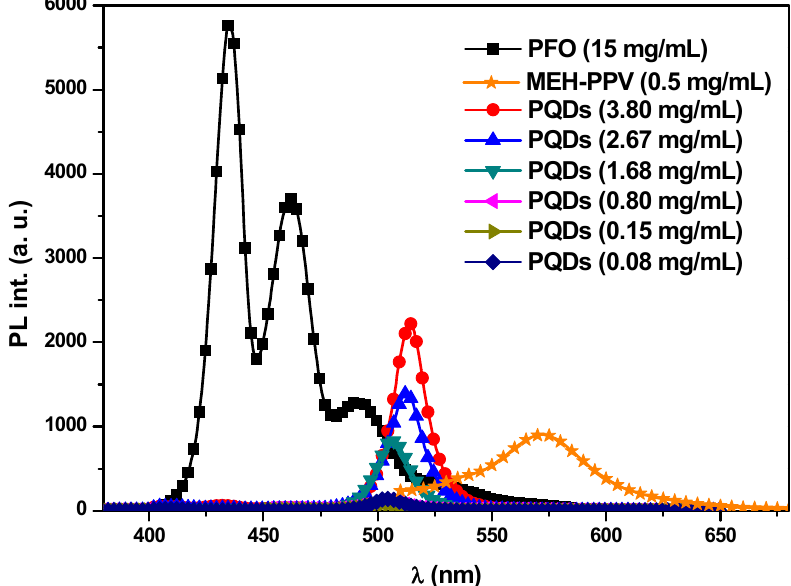
Figure 2. Photoluminescence spectra of pristine PFO, MEH-PPV, and PQDs at specific concentrations that were equal to the ratios utilized for the hybrids.